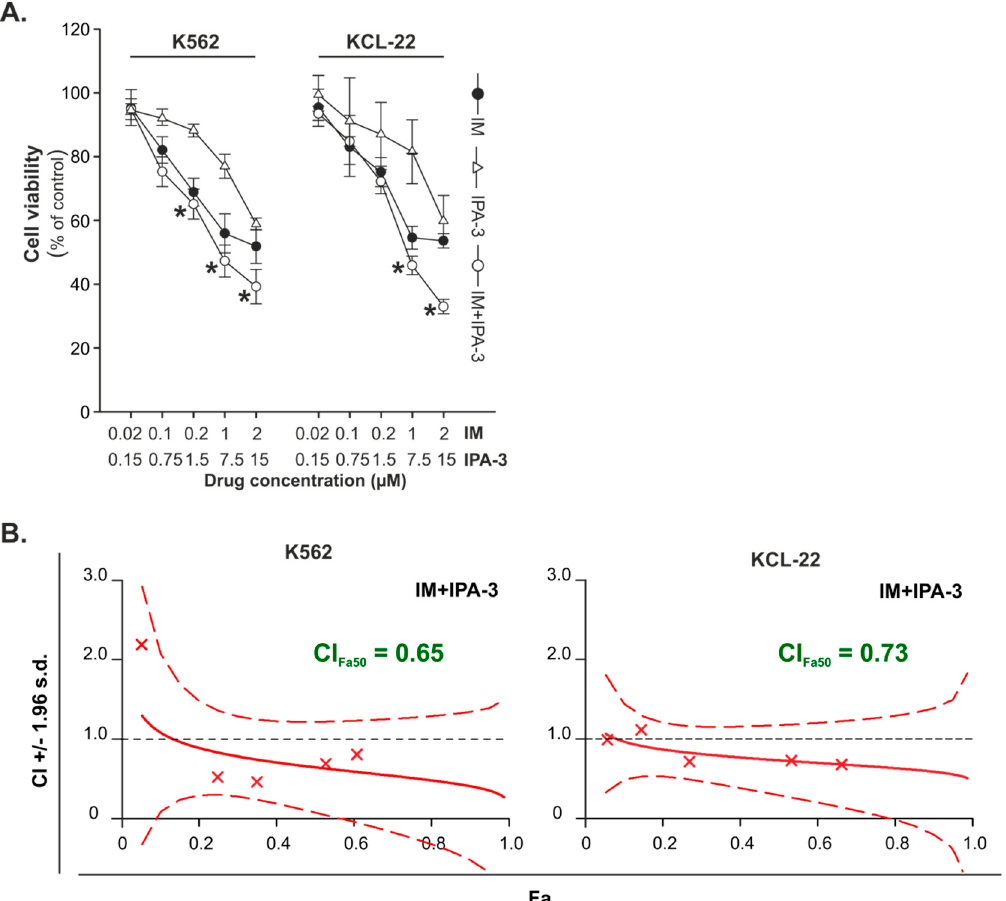
Figure 1. Effect of imatinib (IM) and IPA-3 on cell viability of chronic myeloid leukemia in the blast phase (CML-BP) cell lines. ( A ) The cells were treated for 24 h with the indicated doses of IM and IPA-3 individually and in combination followed by 3-(4, 5-dimethylthiazol-2-yl)-2,5-diphenyltetrazolium bromine (MTT) assay to test cell viability. Each point represents the mean ± standard deviation (SD) (n ≥ 4), * p < 0.05 in comparison with imatinib. ( B ) Combination index (CI) values with a 95% confidence interval at all effective levels indicate the nature of the interactions (CI = 1 = additivity, CI < 1 = synergy, CI > 1 = antagonism). Fa is the fraction of cells affected by combination treatment.